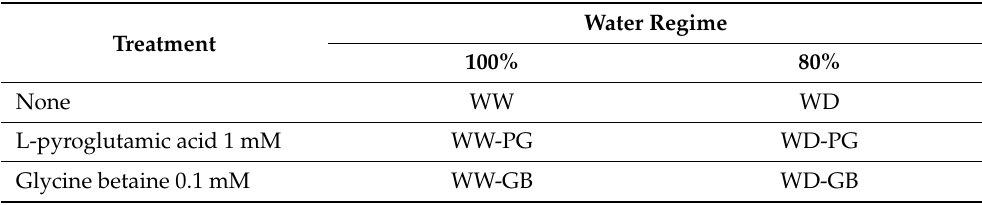
Table 1. Treatment and water conditions